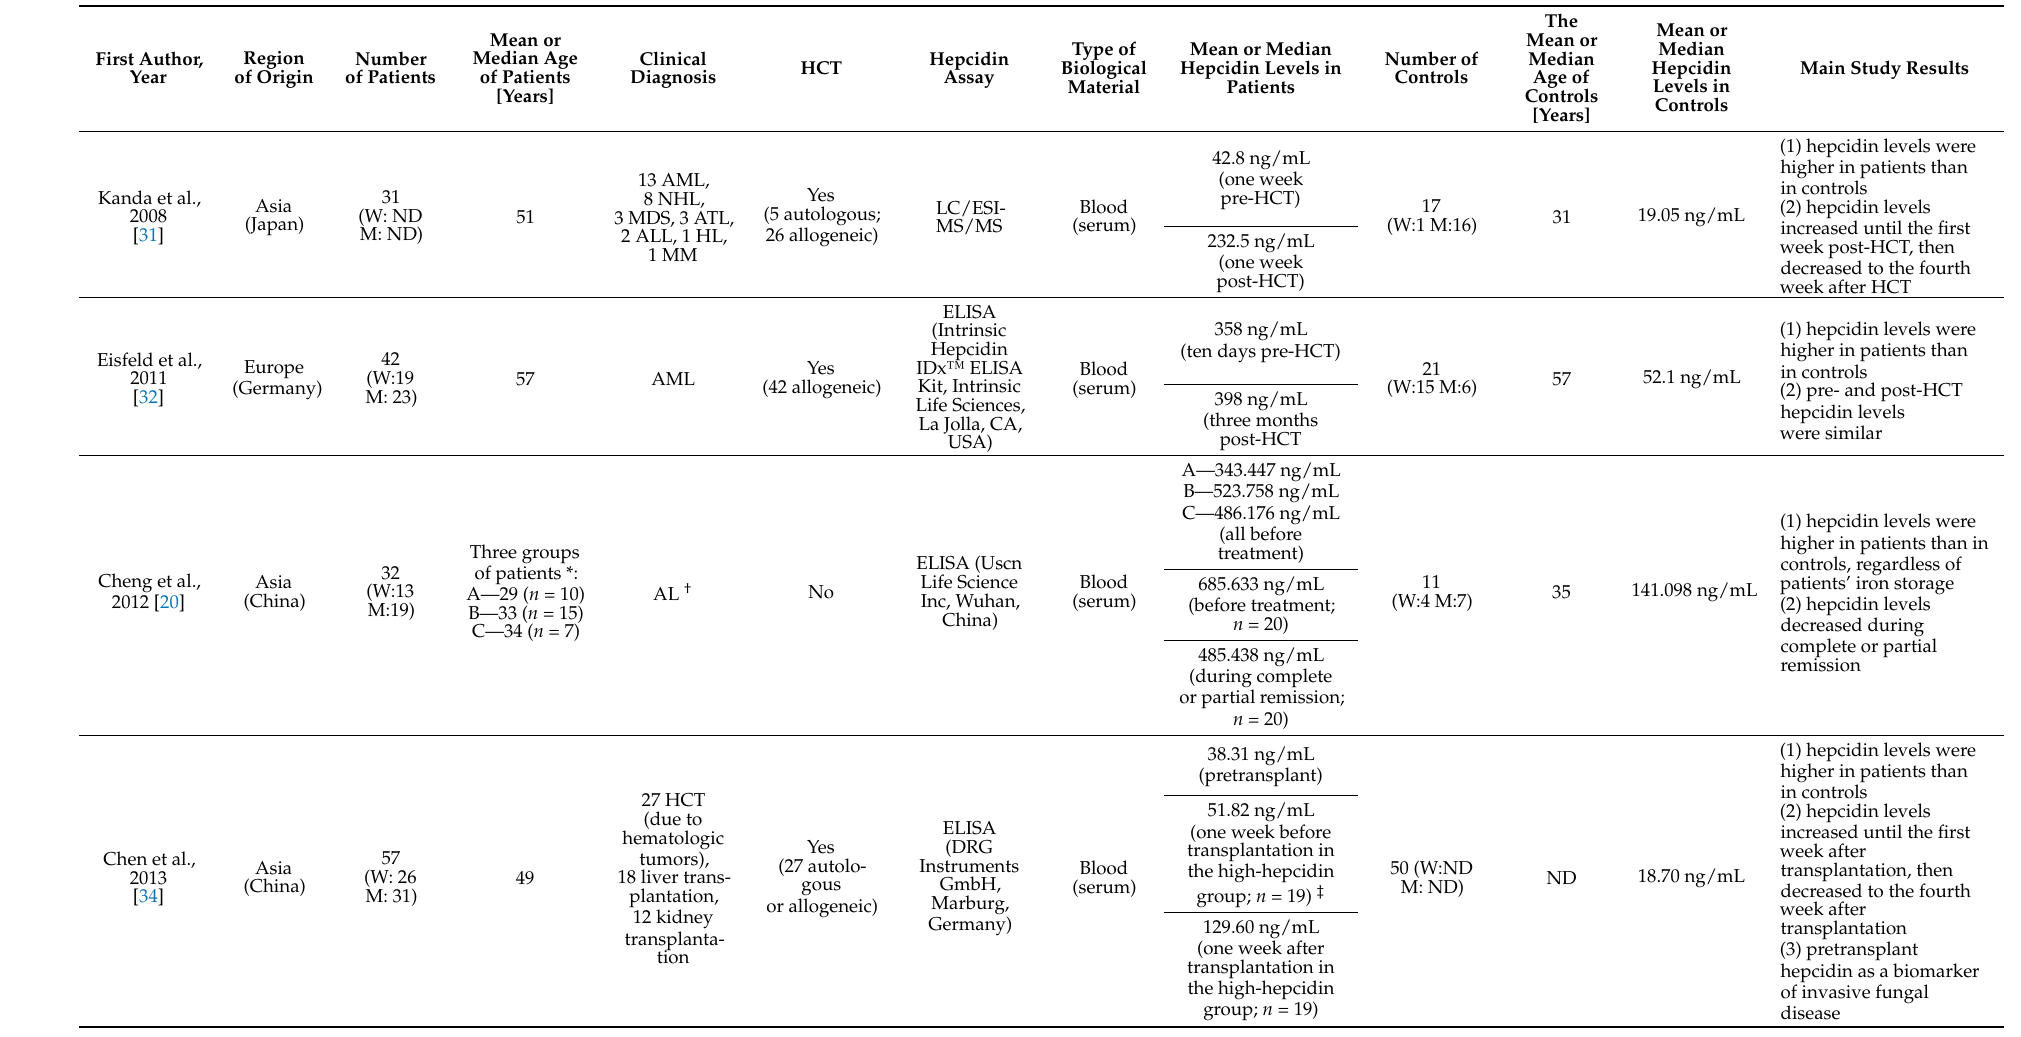
Table 1. Characteristics of the seven case-control studies included in a systematic